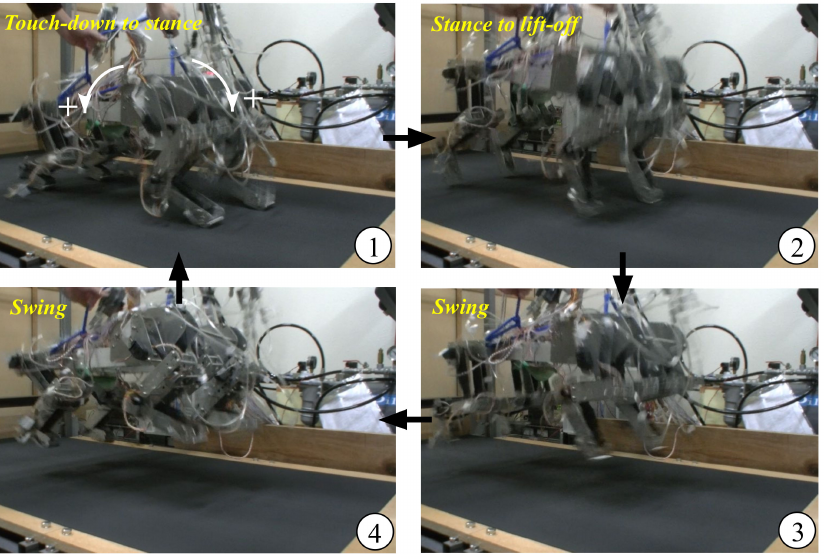
Figure 7. Snapshots of our quadruped robot running at a pace. 1 (cid:13) – 4 (cid:13) indicate the running sequence.